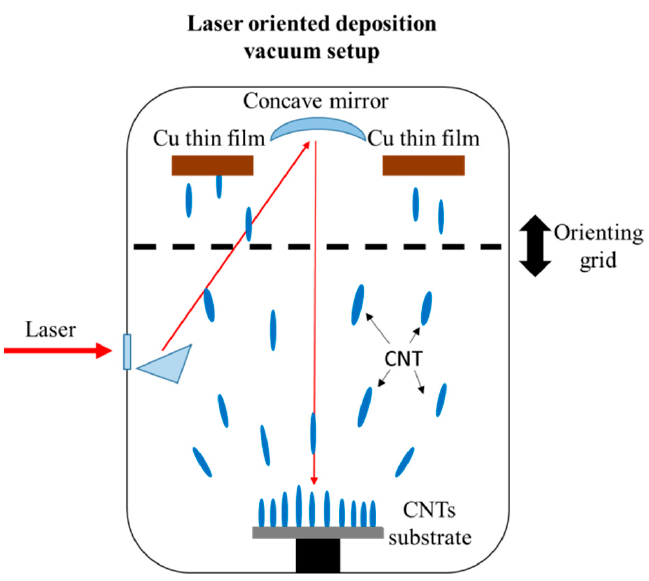
Figure 1. The laser-oriented deposition scheme used for the Cu-surface modification.